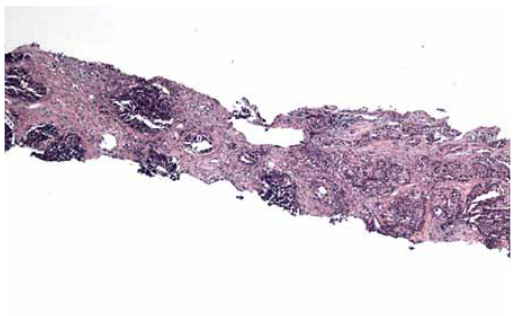
Figure 2 - Small cell carcinoma associated with acinar adenocarcinoma. On the upper right corner, small cell carcinoma predominates, whereas acinar Gleason pattern 3 can be seen in the left lower corner. Hematoxilin-eosin, 200x.